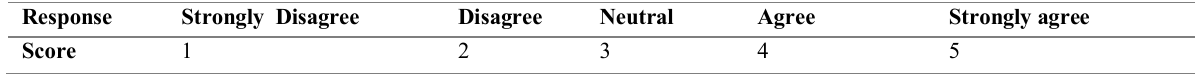
Table 3: The Scale fivefold